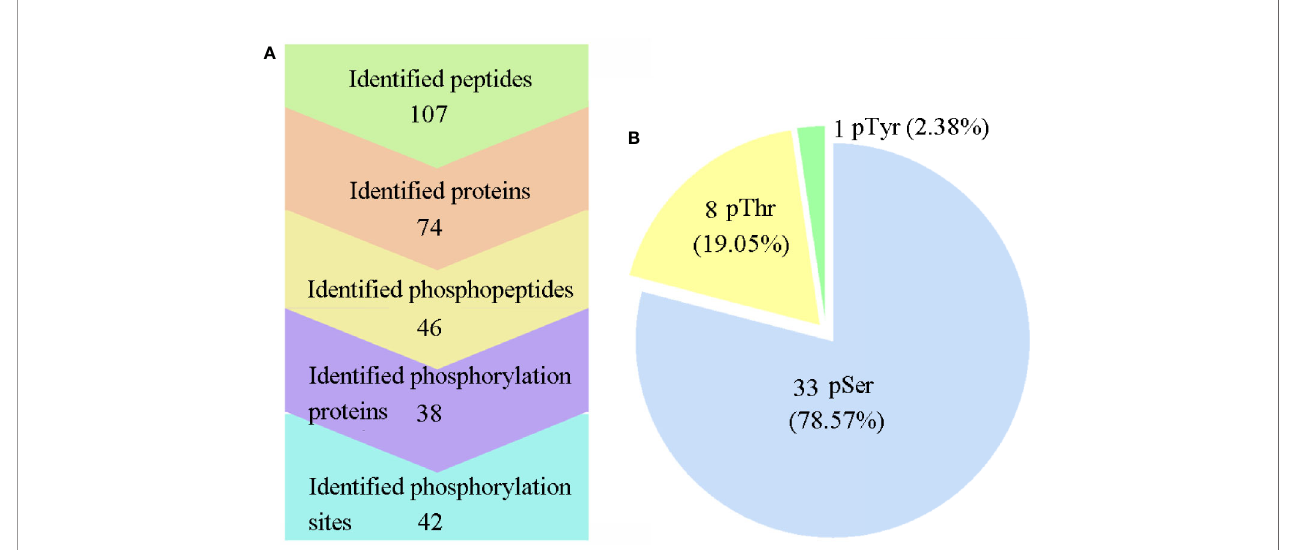
FIGURE 2 | Large-scale mass spectra information regarding the phosphoproteome data. (A) Information on the identi fi ed proteins, phosphoproteins, peptides, phosphopeptides, and phosphosites. (B) Distribution of the pSer/pThr/pTyr phosphoproteome. Phospho-Ser was the most abundant site, and it accounted for 78.57% of all phosphorylated amino acids, followed by phospho-Thr (19.05%) and phospho-Tyr (2.38%).